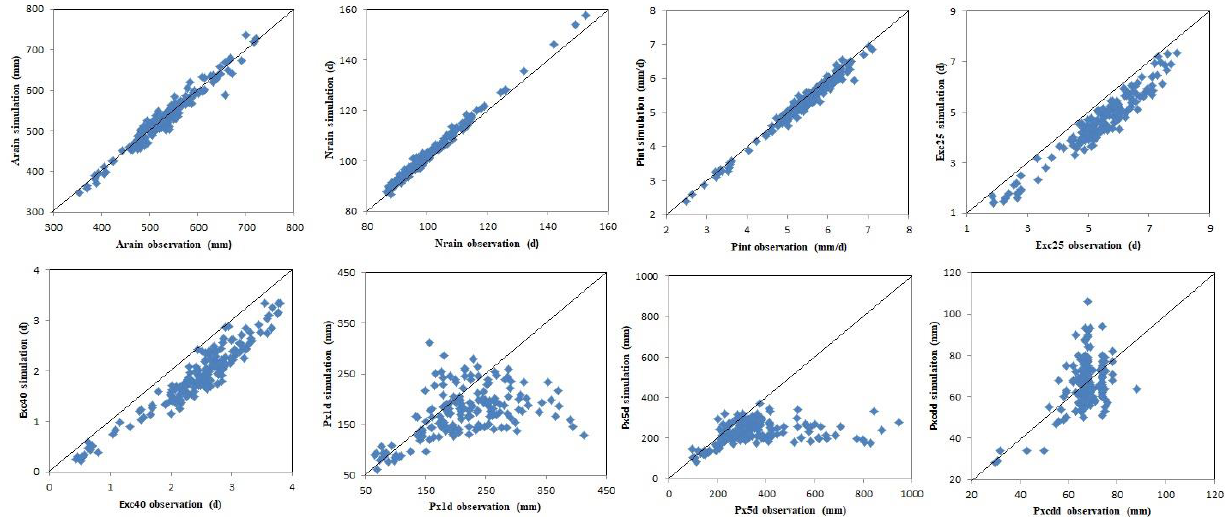
Figure 2. Comparison of the observations and simulations based on the eight precipitation indices. The evaluation is done on an annual scale, each symbol corresponds to one station.